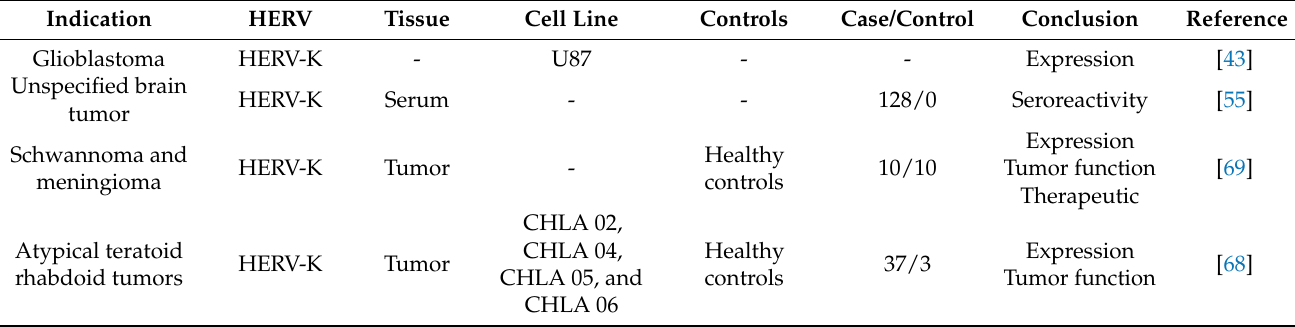
Table 2. HERV protein expression in neurological